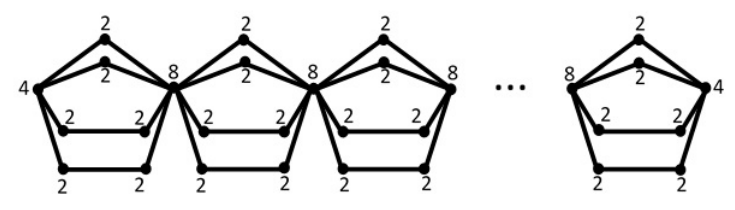
Figure 1 Pentagonal double chain C 2